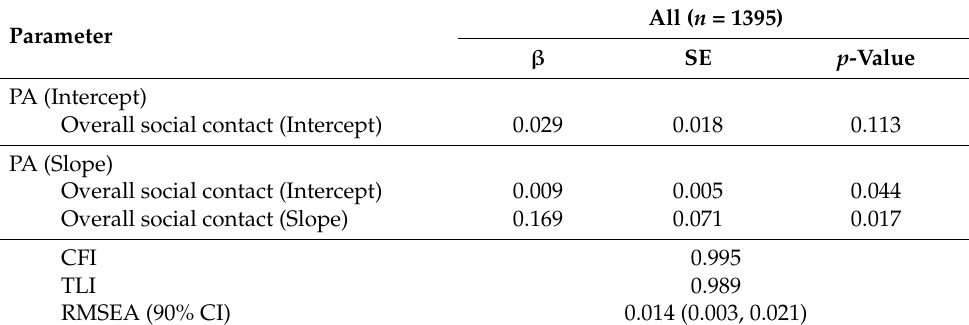
Table 2. Estimated coefficients of the parallel latent growth curve model (Model 1) a .